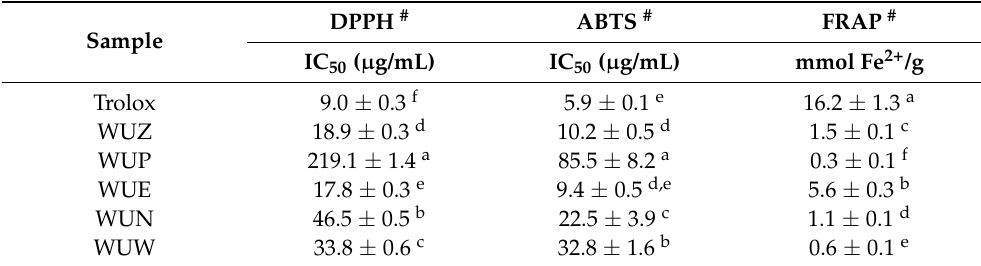
Table 1. Antioxidant activities of different extracts from stem barks of W. ugandensis tested by DPPH, ABTS, and FRAP assays.